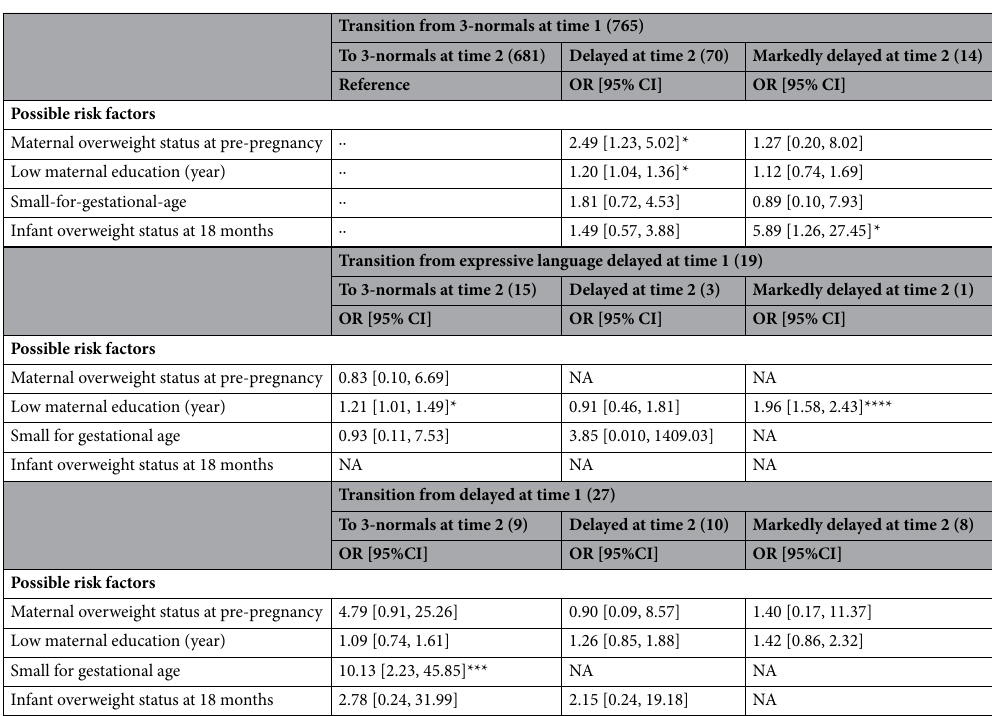
Maternal overweight status at pre-pregnancy 0.83 [0.10,